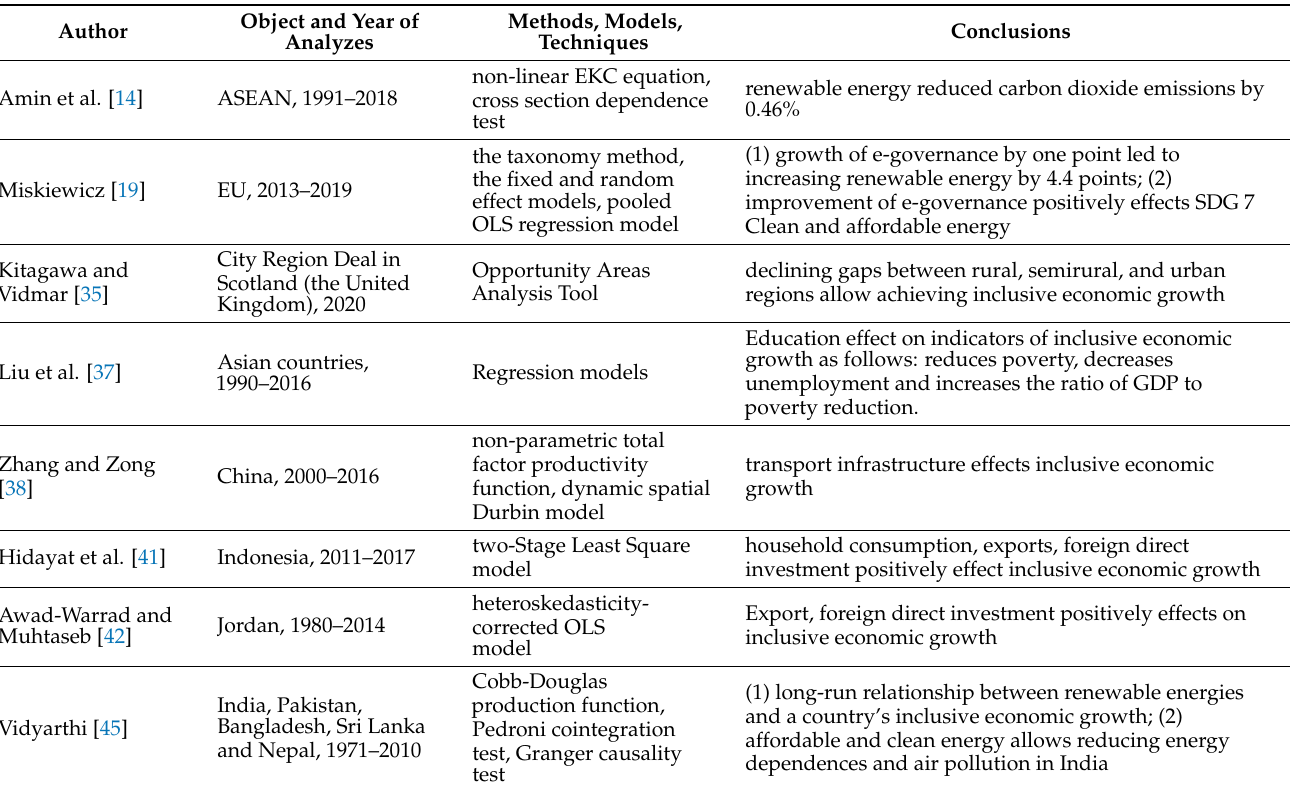
Table 1. Summary of empirical research on links between energy and governance efficiency for inclusive economic